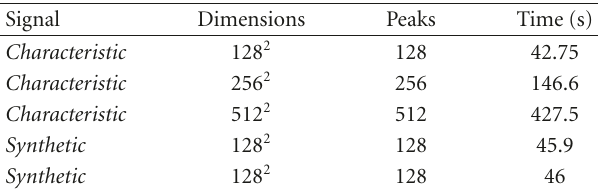
Table 2: Dimensions, number of peaks, iterations, reconstruction accuracy, and running times for spectra.